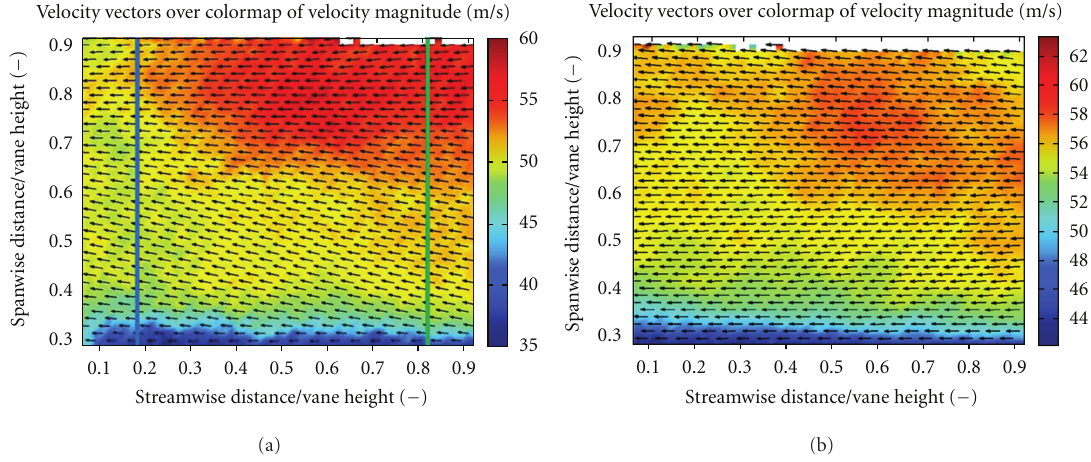
Figure 15: Velocity vectors with magnitude as background color for experimental planes (a) near the cavity channel (3mm plane) and (b) far from the cavity channel (9mm plane). Data is shown for the straight channel, with the main flow of 1.53 kg/s and a cavity flow of 0.15kg/s . Vertical lines on (a) mark the position of leading (0.8) and trailing (0.2) edge of RVC axial position.